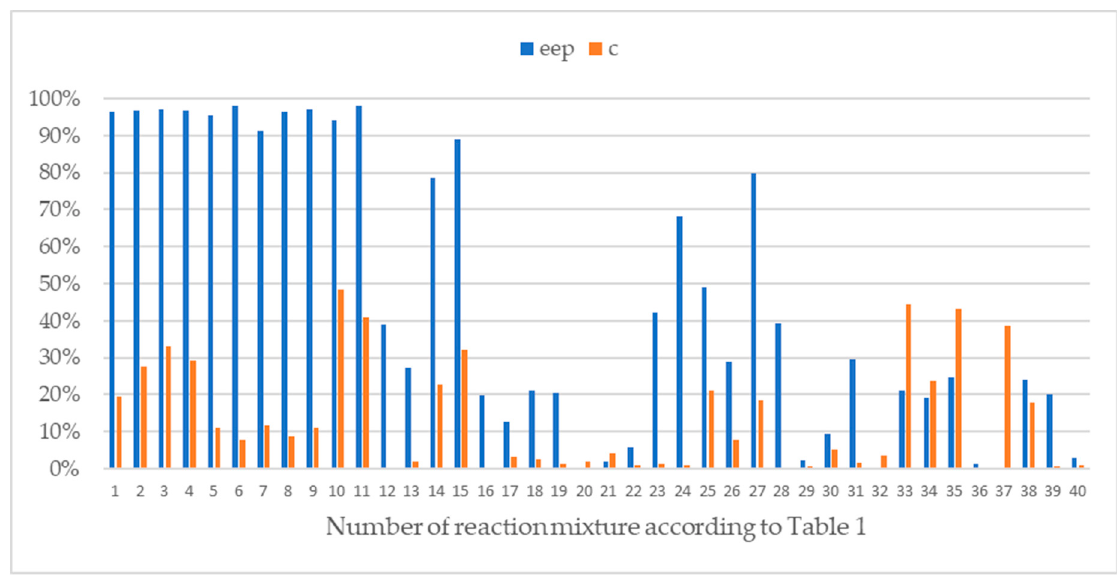
Figure 6. Enzymatic parameters of the performed kinetic resolution including enantiomeric excesses of products (ee p ) and conversion (c) of different reaction media screened for the enantioselective acetylation of ( R , S )-phenylethanol after 168 h of incubation.